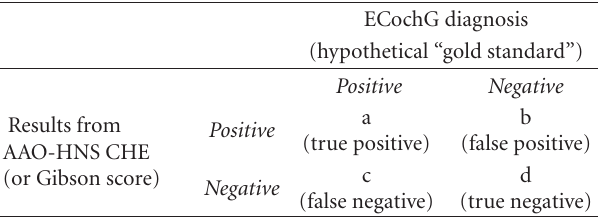
Table 4: Formula for calculating the diagnostic power of the two subjective tests, respectively, as compared with the diagnosis based on ECochG measures.